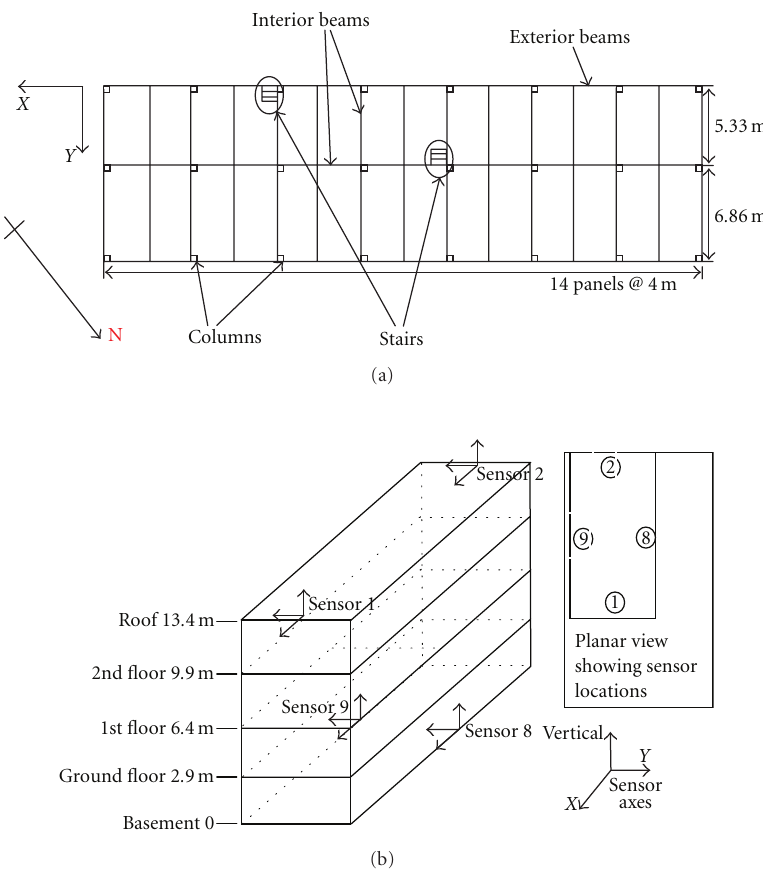
Figure 3: Building B: (a) typical floor plan showing location of stairs and (b) sensor